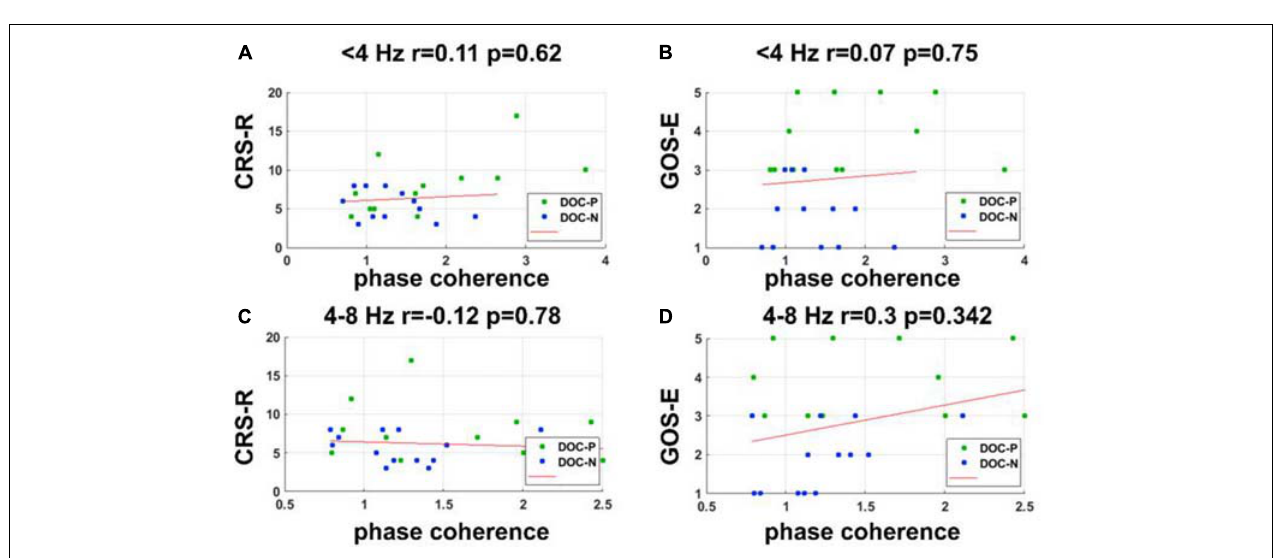
FIGURE 5 | Correlations between neural synchronization at 2 and 4 Hz, and clinical evaluations. (A–D) Correlations between phase coherence at 2, 4 Hz, and CRS-R, GOS-E scores. Correlations between the phase coherence at 2, 4 Hz, and CRS-R, GOS-E were not statistically significant.